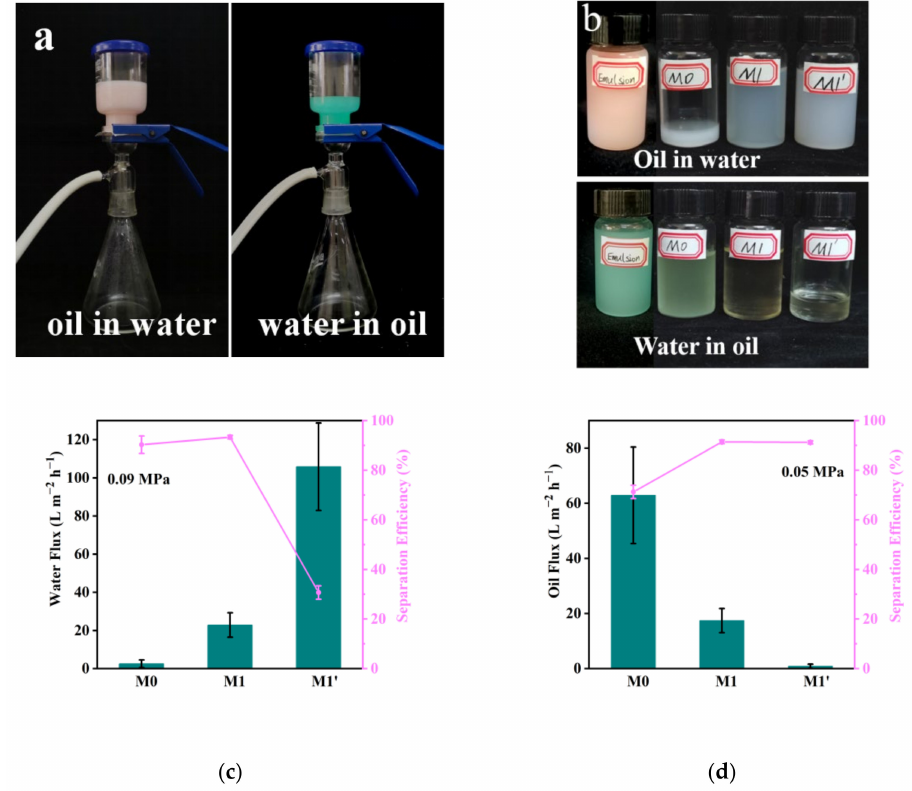
Figure 7. The switchable oil–water (O/W, W/O) emulsion separation test of M0, M1, and M1 (cid:48) : ( a ) the device of emulsion decompression separation; ( b ) the emulsions and filtrates after decom- pression separation via three types of membranes; ( c , d ) water flux and oil flux as well as separation efficiency of the three types of membranes,